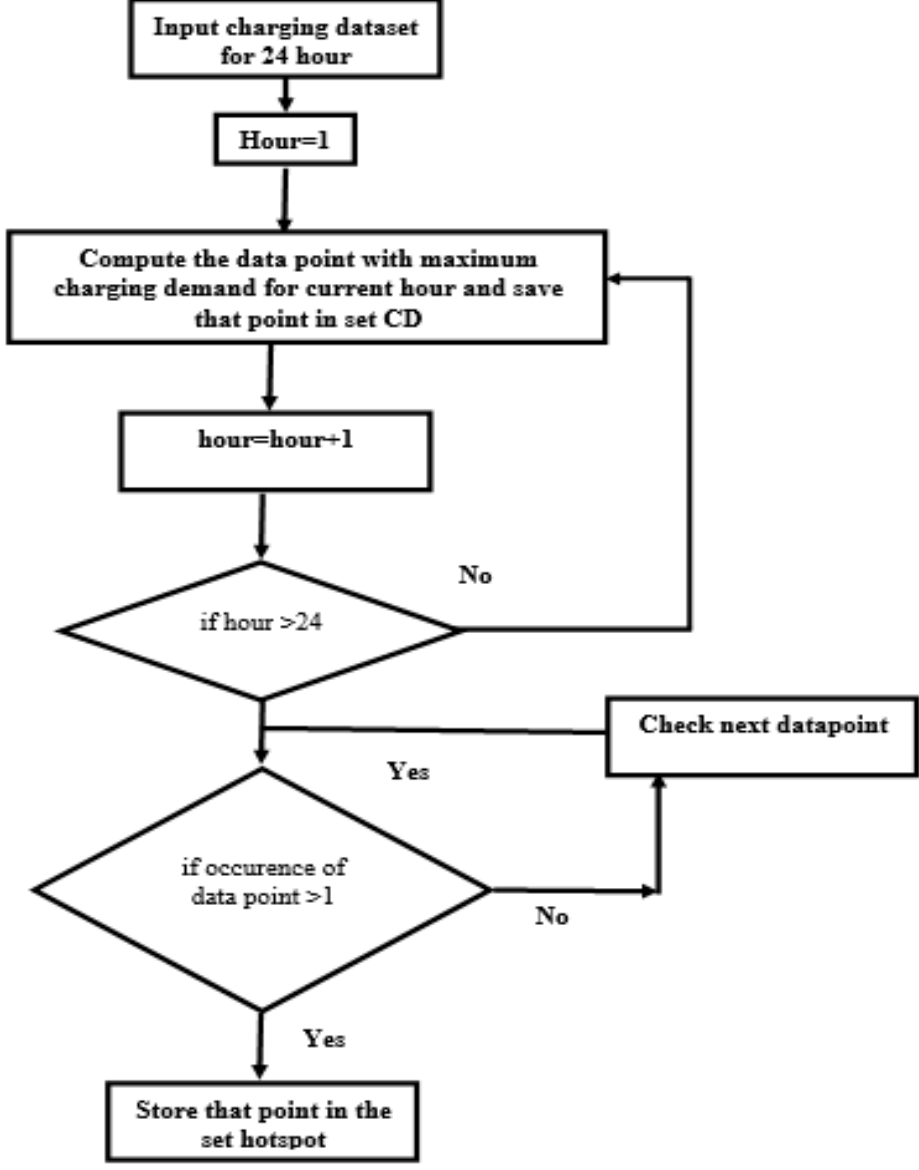
Figure 4. Flowchart for the computation of home charging hotspots [105]. Table 4. Home charging hotspots for Helsinki [105]. Latitude